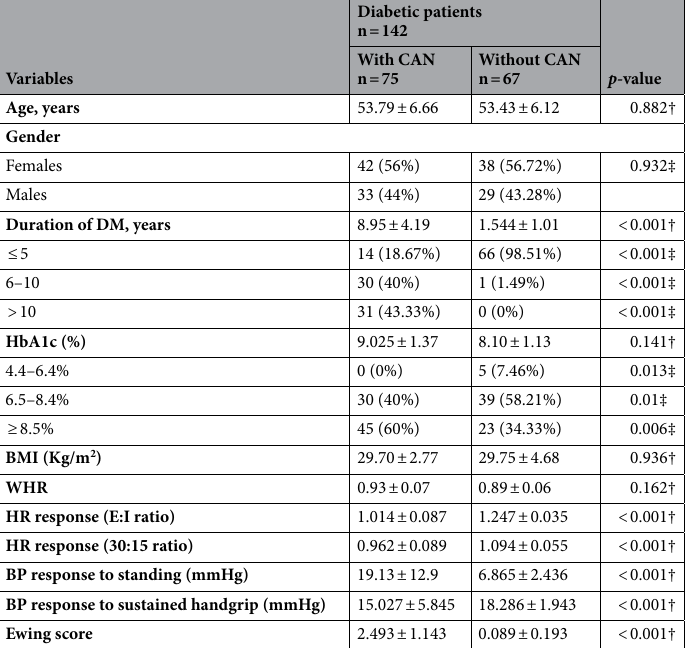
Table 3. Demographic and Ewing’s tests values of diabetic patients with and without CAN. CAN = cardiac autonomic neuropathy; BMI = body mass index; WHR = waist/hip ratio; HR = heart rate; E: I = expiration: inspiration; BP = blood pressure, † t-test; ‡